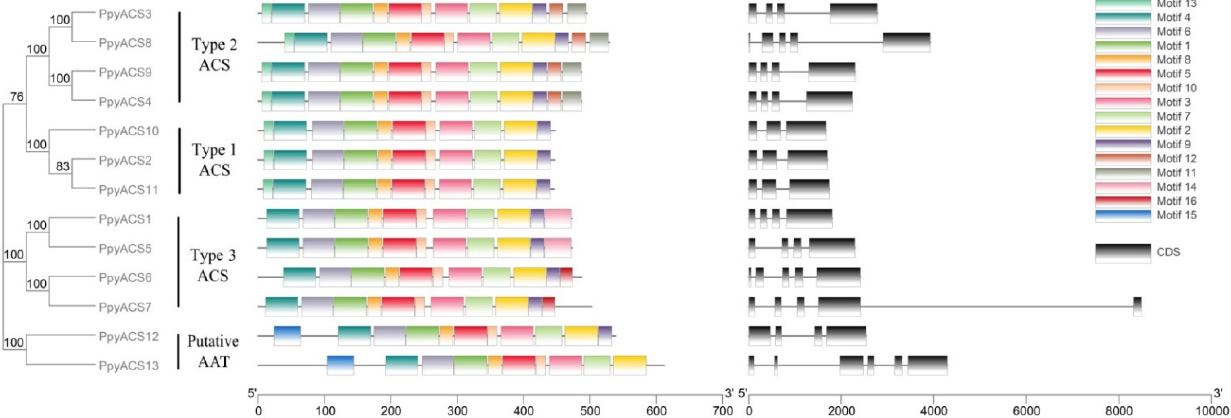
Figure 2. The phylogenetic relationship, conserved motifs and CDS structure of PpyACS proteins. A phylogenetic tree of the PpyACS protein family ( left side ) was constructed by MEGA7 using the Neighbor-Joining (NJ) method and 1000 bootstraps. The distribution of 16 conserved motifs across PpyACS protein ( middle side ) was predicted by the MEME (Multiple Em for Motif Elicitation) tools. The CDS structure of PpyACS genes were shown on the ( right side ). The sequences and lengths of motifs among PpyACS proteins were presented in Table S4.